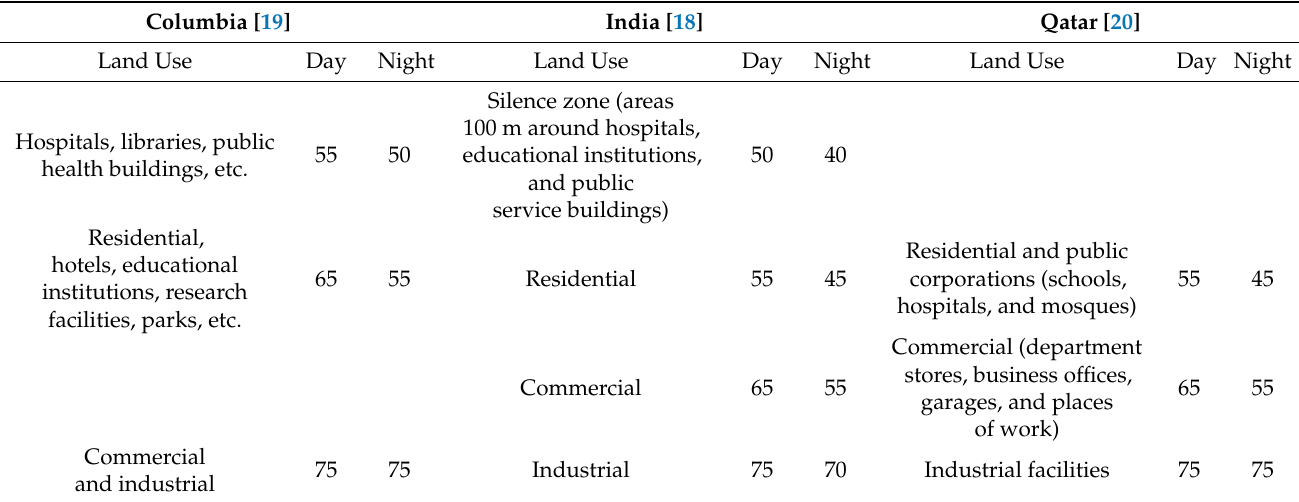
Table 2. Land use or area-specific noise level threshold guidelines as per Columbia, India, and